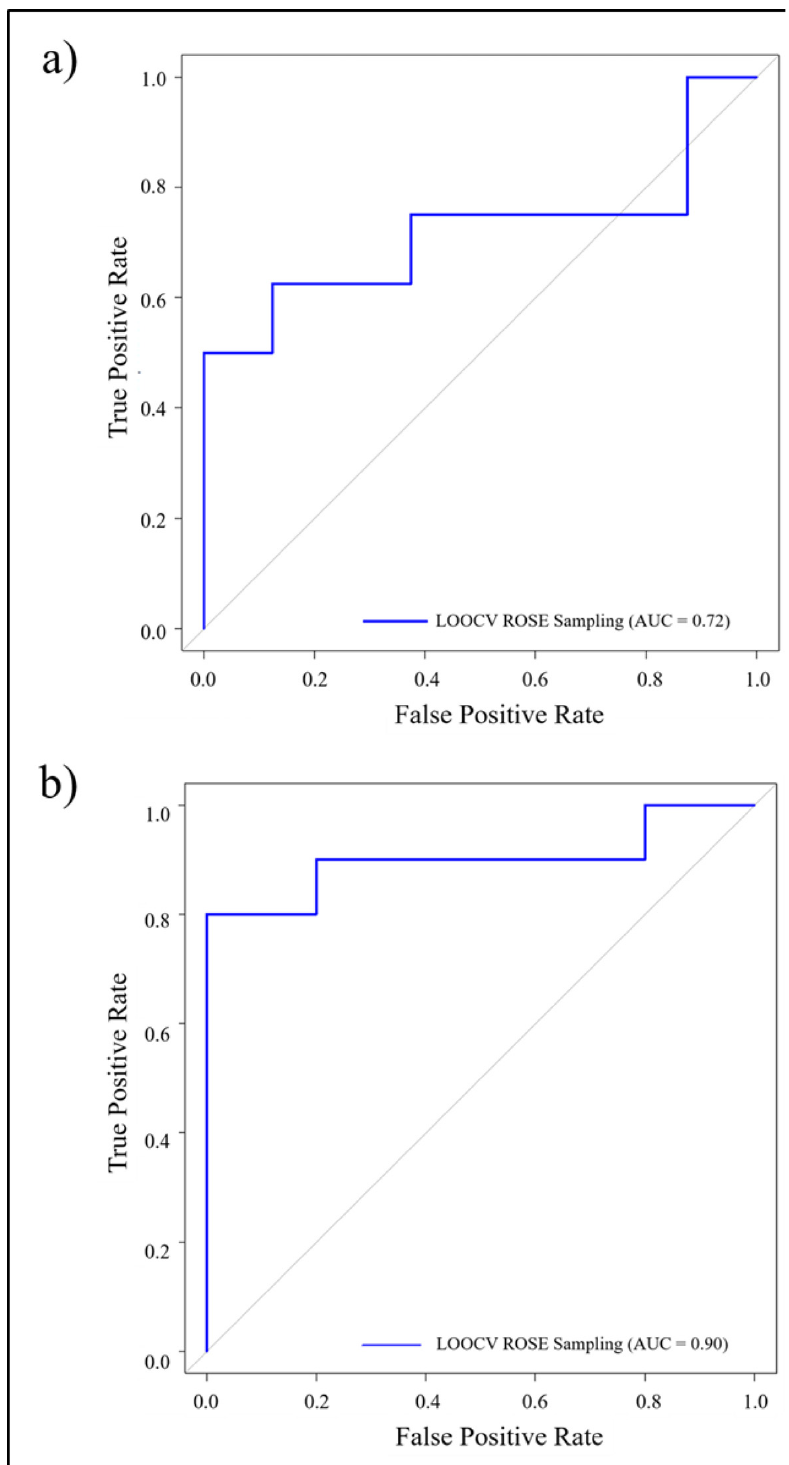
Figure 5. ROC curves and AUC values from the testing dataset derived from the best-performing random RF included ( a ) Australia mainland landfall, and ( b ) SWPO islands landfall (both in blue color). For both mainland and island events, LOOCV with ROSE sampling RF models provided the highest sensitivity, specificity, and AUC score .